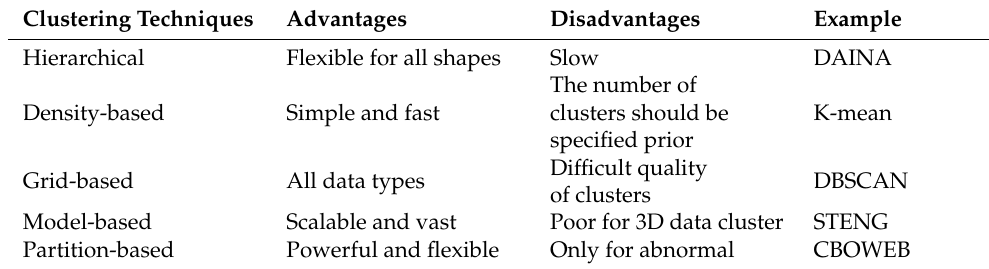
Table 1. Differences between the various clustering